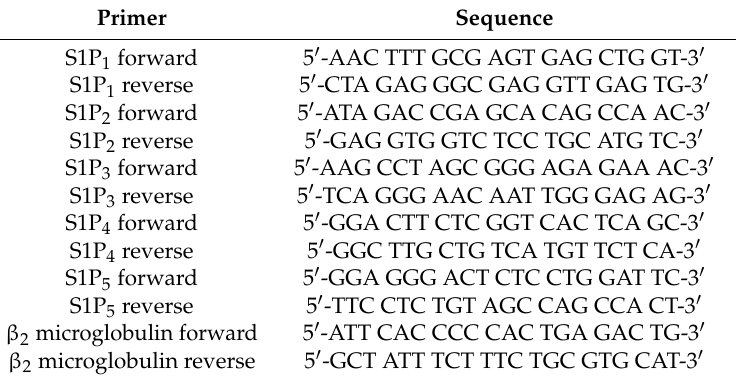
Table 1. Primer sequences used for quantification of Sphingosine-1-phosphate (S1P) receptor subtypes and β 2